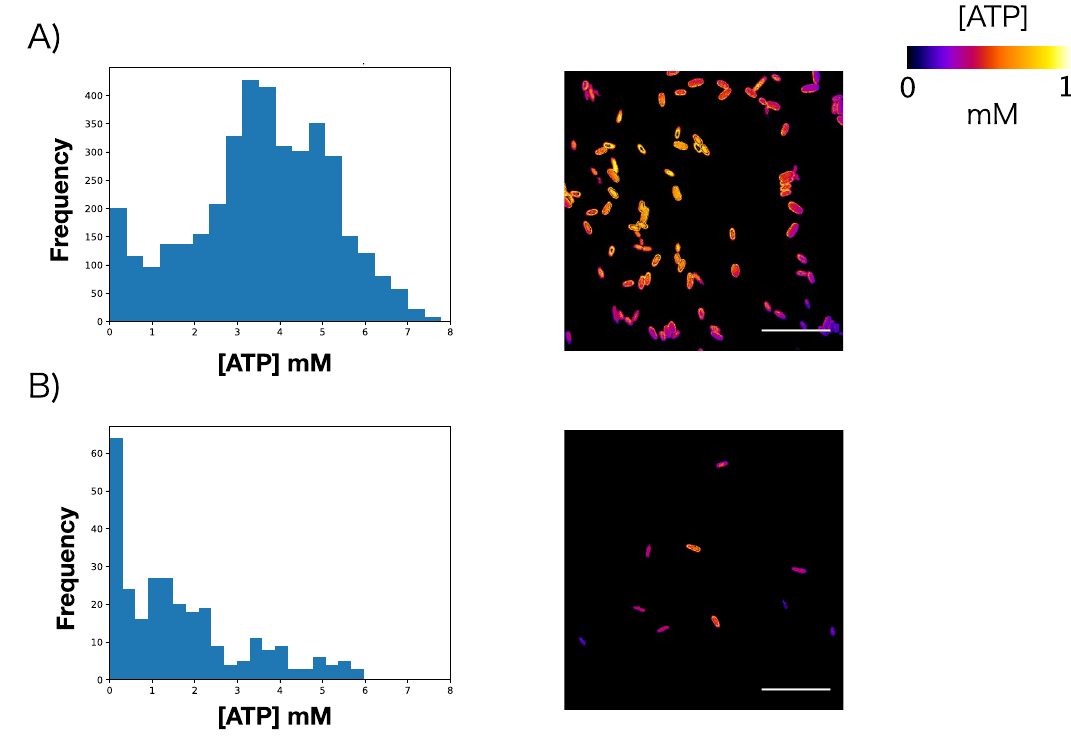
Figure 1. Diversity in intracellular ATP concentration in individual E. coli cells under glucose-deficient conditions. ( A ) Histogram of intracellular ATP concentrations of individual E. coli cells under control conditions (22.2 mM glucose; skewness = − 0.273, n = 3919) and a microscopic image of color-rendered ATP concentrations in individual cells. ( B ) Histogram of intracellular ATP concentrations of individual E. coli under glucose-deficient conditions (0.1 mM glucose; skewness = 0.972, n = 359) and a microscopic image of color- rendered ATP concentrations in individual cells. Scale bar, 10